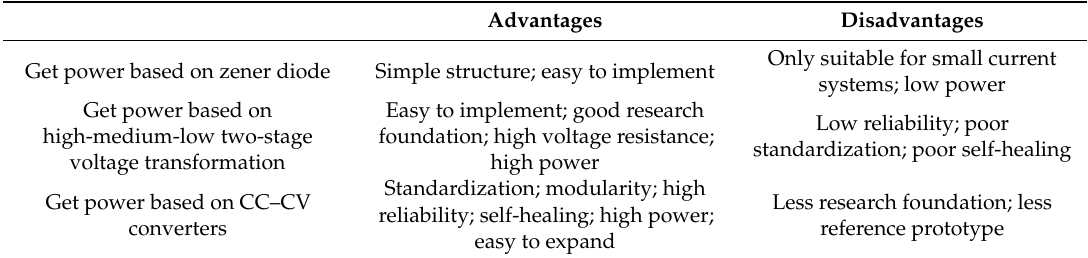
Table 1. Comparison of three main ways to obtain constant voltage (CV) piezoelectric energy